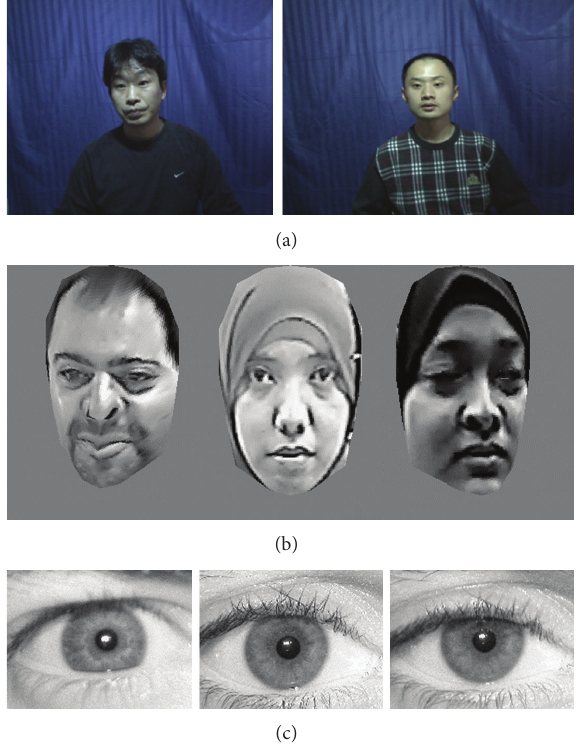
Figure 3: Sample images from (a) CASIA face dataset, (b) 2.5D face dataset, and (c) UBIRIS iris